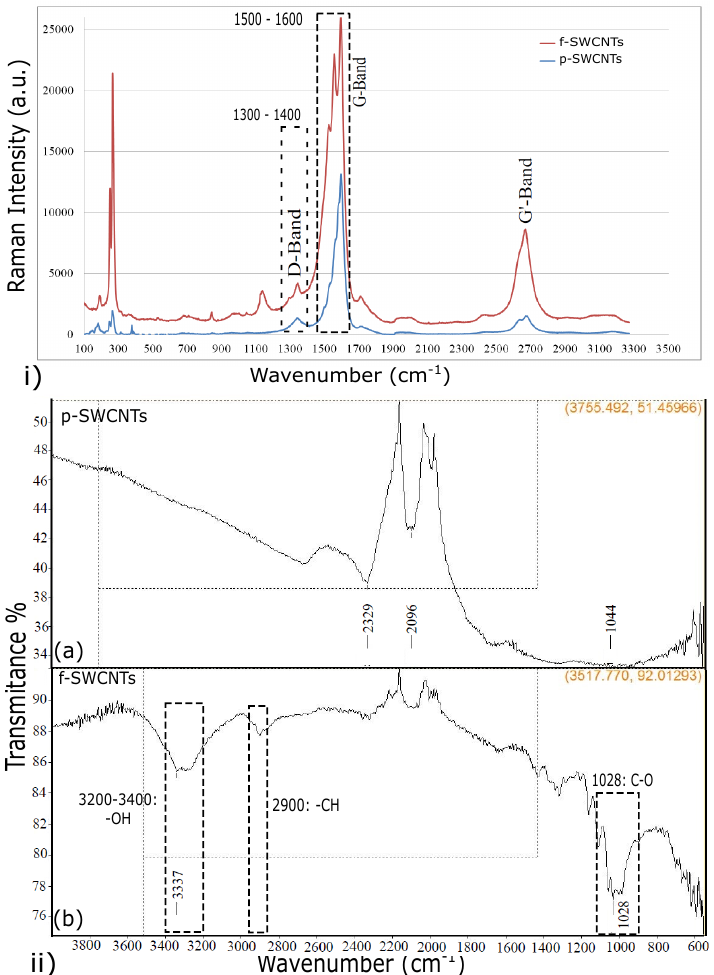
Figure 2. ( i ) Raman spectra of p-SWCNTs and f-SWCNTs. ( ii ) FTIR spectra of ( a ) p-SWCNTs and ( b ) f-SWCNTs.